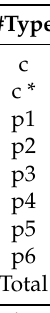
Table 5. Statistical table of SSR analysis results.